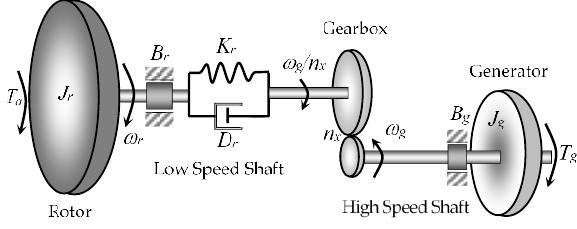
Figure 1. Drivetrain described by a two-mass system with a gearbox.